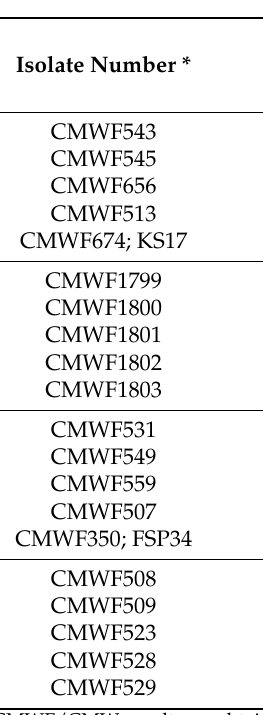
Table 1. Fusarium circinatum isolates used in this Study.